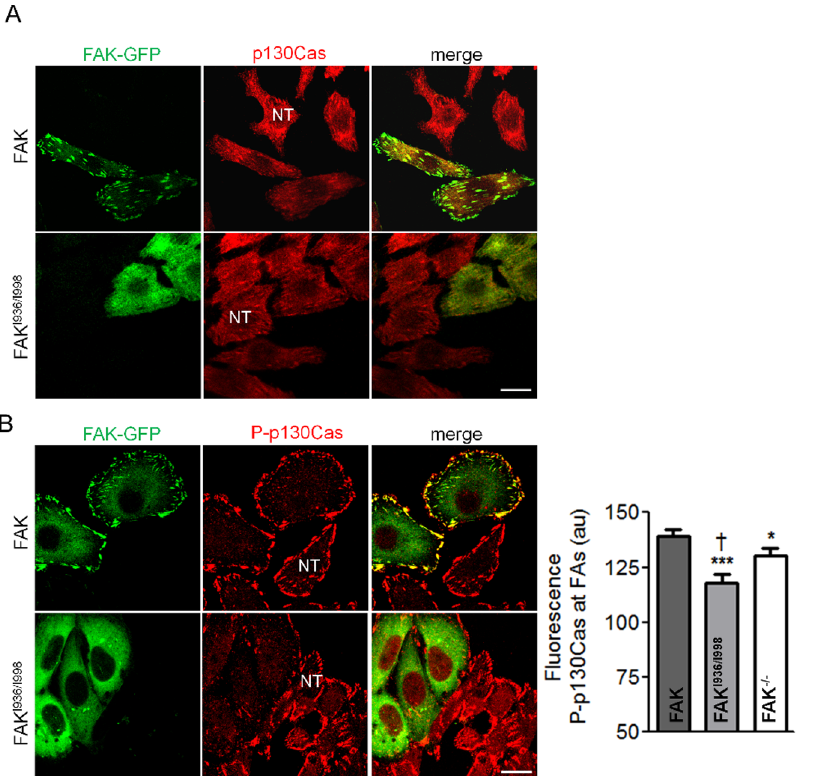
Figure 9. p130Cas distribution in FAK -/- , wild-type FAK and FAK I936/I998 cells. (A) Confocal images of fixed FAK -/- cells expressing or not (NT, non-transfected cells) wild-type or mutant FAK-GFP (left panel) and immunostained for p130Cas (right panel). Note the localization of p130Cas at FAs in both FAK -/- , FAK I936/I998 and FAK cells. Scale bar, 20 m m. (B) Confocal images of fixed FAK -/- cells expressing or not (NT, non-transfected cells) wild- type or mutant FAK-GFP (left panel) and immunostained for P-p130Cas (right panel). Note the high level of P-p130Cas at FAs in GFP-FAK cells (upper panel) and the lack of P-p130Cas staining at FAs in FAK I936/I998 -GFP cells (lower panel). Scale bar, 20 m m. Quantification of the mean fluorescence intensity at FAs shows a significant reduction of P-p130Cas staining for both FAK I936/I998 compared to FAK and FAK -/- cells and for FAK -/- cells compared to FAK cells (P=0.0005, F=9.434; ***p , 0.0005, *p , 0.05 and { p , 0.05 respectively, n=3 independent experiments with 12 to 15 cells analyzed and more than 300 FAs analyzed for each